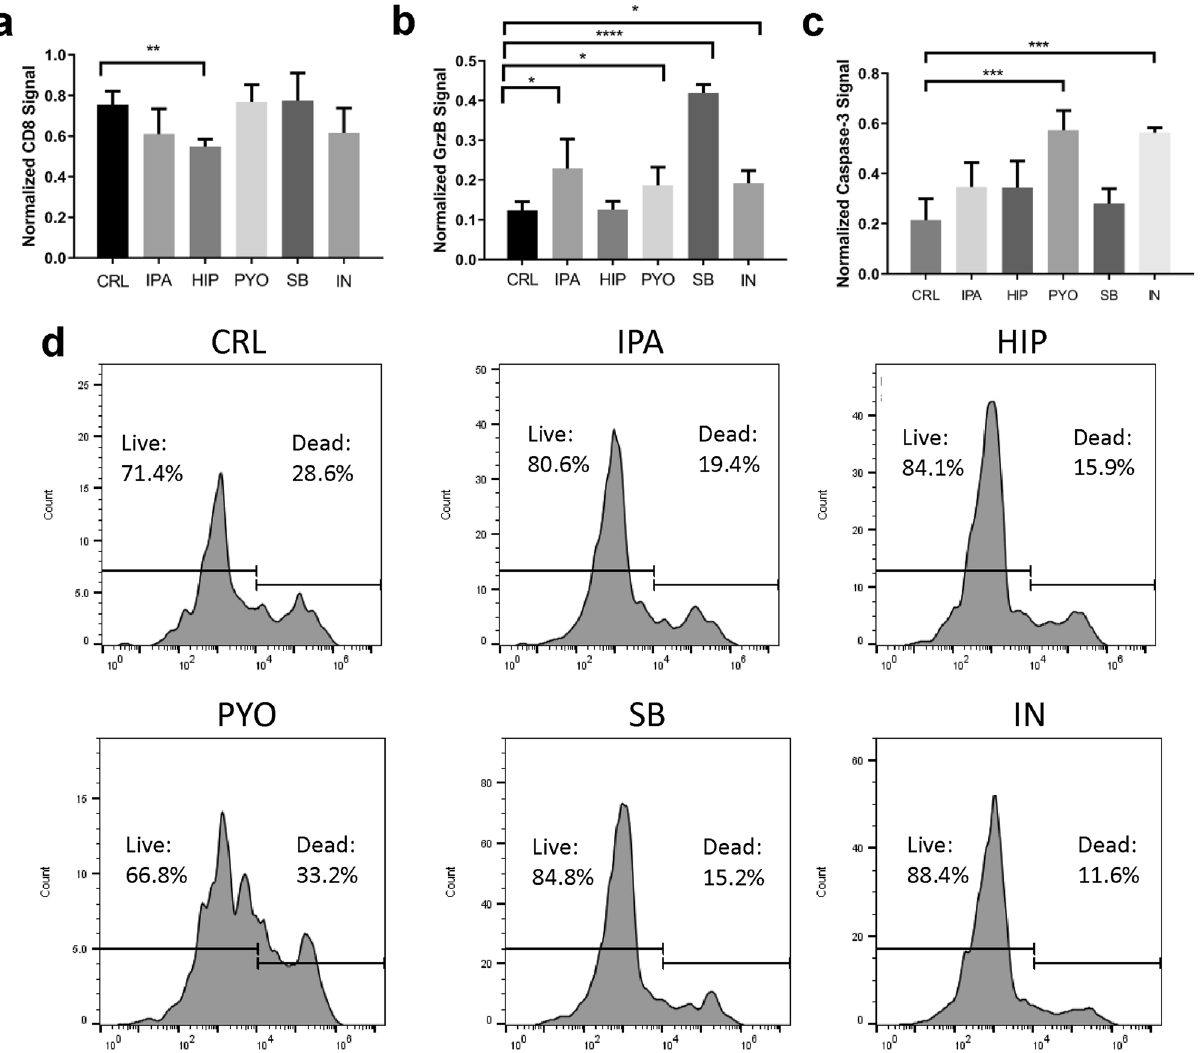
Figure 5. The effects of bacterial metabolites on immune responses in iTOs. ( a – c ) CD8 ( a ), Granzyme B ( b ), and cleaved caspase-3 signals ( c ) normalized to DAPI signal in iTOs (n = 4 ROI). ( d ) The effects of bacterial metabolites on CD8 + immune cell population viability (data representative of 3 organoids